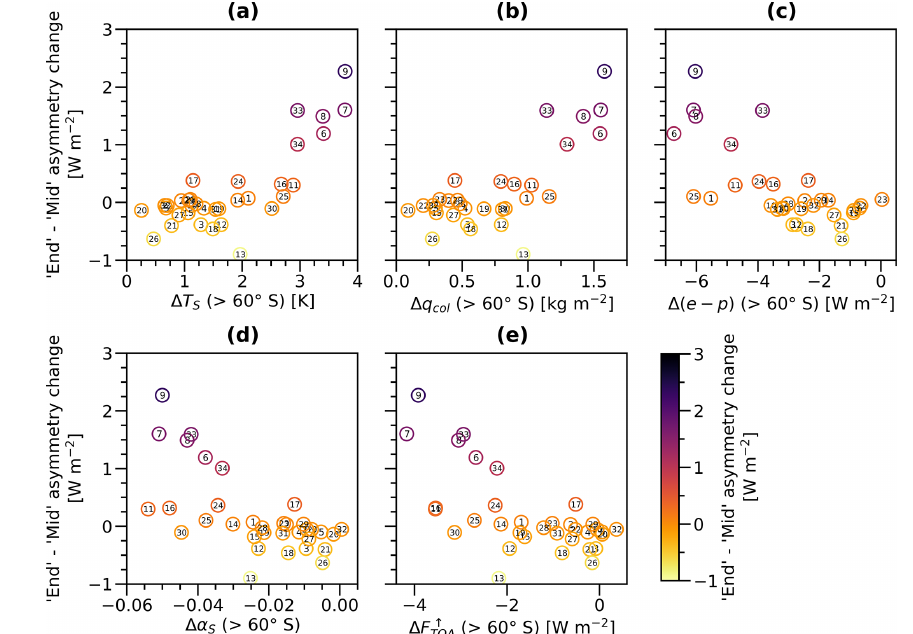
Figure 4. Mean asymmetry changes plotted against SH polar ( > 60 ◦ S)-area mean changes in (a) near-surface air temperature T S , (b) verti- cally integrated atmospheric moisture content q col , (c) evapotranspiration minus precipitation ( e − p ) expressed in energetic units, (d) surface ↑ albedo α S , and (d) TOA upwelling SW radiation F between Mid and End. Markers denote models as they are numbered in Table 1. The TOA color scale depicts changes in asymmetry between End and Mid.